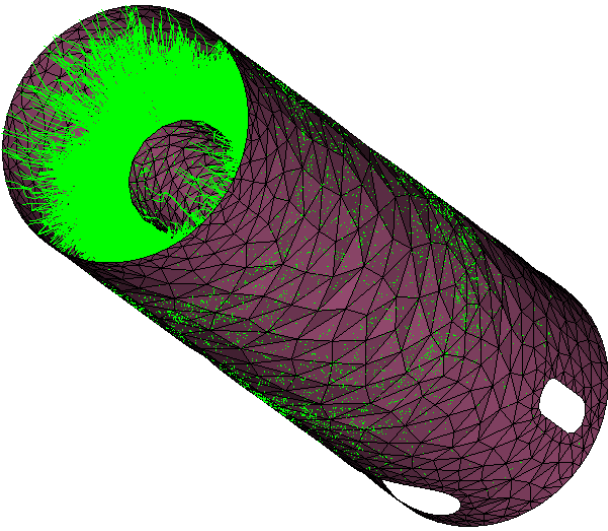
FIG. 7. (Color) Enhance counter functions after 5, 10, and 20